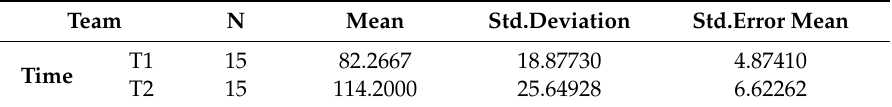
Table 10. Group Statistics: Mean Time for two Teams.